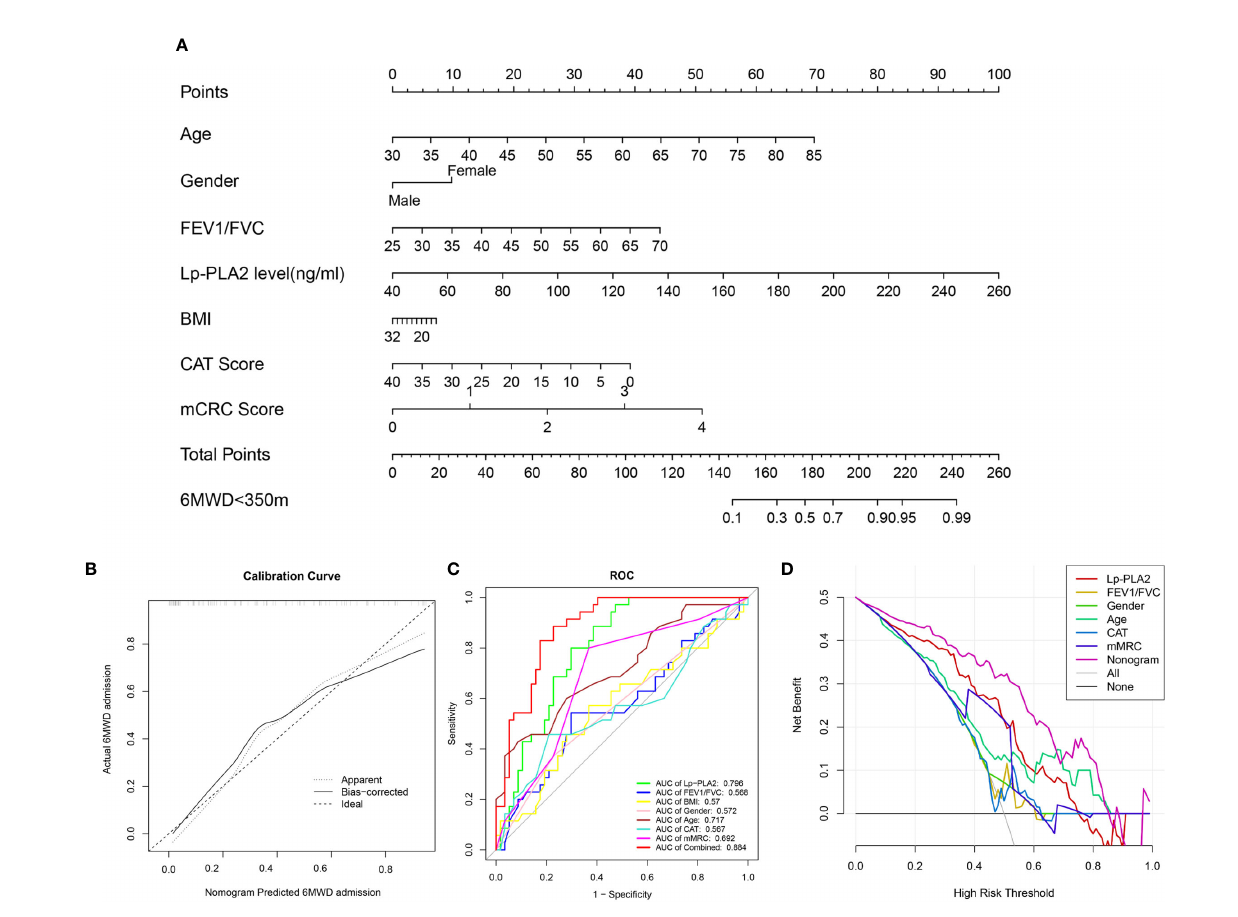
FIGURE 7 | Construction of nomogram model. (A) Nomogram predicting 6MWD<350m for COPD patients; (B) Calibration curves for nomogram predicted 6MWD<350m for COPD patients; (C) ROC curve analysis show highest AUC value was seen for the nomogram model; (D) Decision curve analysis (DCA) shows the net bene fi t in 6MWD<350m predictions was the highest in nomogram